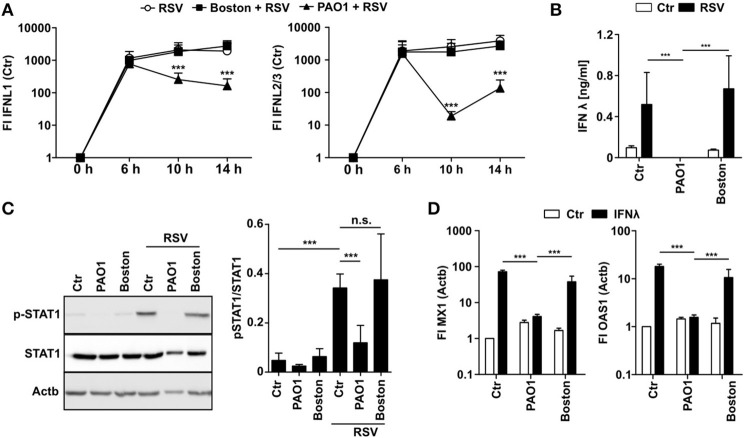
P. aeruginosa is able to block IFN induction and signaling. (A) BEAS2B cells were pretreated with conditioned medium of P. aeruginosa (PAO1 and Boston) or control medium and subsequently infected with RSV. Induction of IFNL1 and IFNL2/3 mRNA were analyzed by qRT-PCR after 6, 10, and 14 h. (B) BEAS2B cells were treated as in (A) and IFNλ levels of cell culture supernatant (14 h) were analyzed by ELISA. (C) BEAS2B cells were treated as in (A) and p-STAT1 levels of cells (6 h) were analyzed in cell lysates by western blot. (D) BEAS2B cells were pretreated as in (A). Cells were then stimulated with recombinant IFNλ (5,000 pg/ml) and induction of MX1 and OAS1 were analyzed after 14 h by qRT-PCR. All experiments n = 3–4, ANOVA and Bonferroni post-test was used for statistical analysis. Significant differences were considered at *p < 0.05, **p < 0.01, and ***p < 0.001 as compared to the control condition. n.s., not significant.